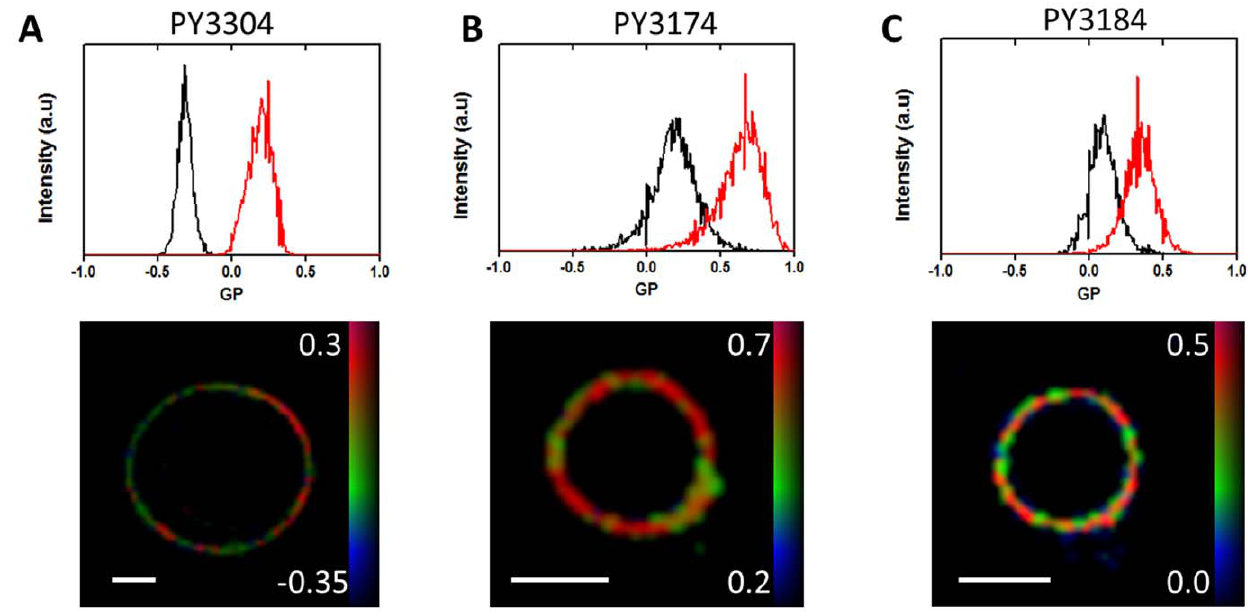
Figure 3. Analysis of Giant Unilamellar Vesicles. Top: Histograms of the GP values obtained from 2-channel confocal images of artificial bilayers in liquid ordered phase (red line) and liquid disordered phase (black line) obtained with PY3304 (A), PY3174 (B), PY3184 (C). Histograms are normalized to the total number of pixels. Bottom: GP images of 1:1:1 DOPC:PSM:cholesterol GUVs showing coexistence of ordered and disordered phase membranes stained with the three probes and imaged by 2-channel confocal microscopy. Scale bar =5 m m.